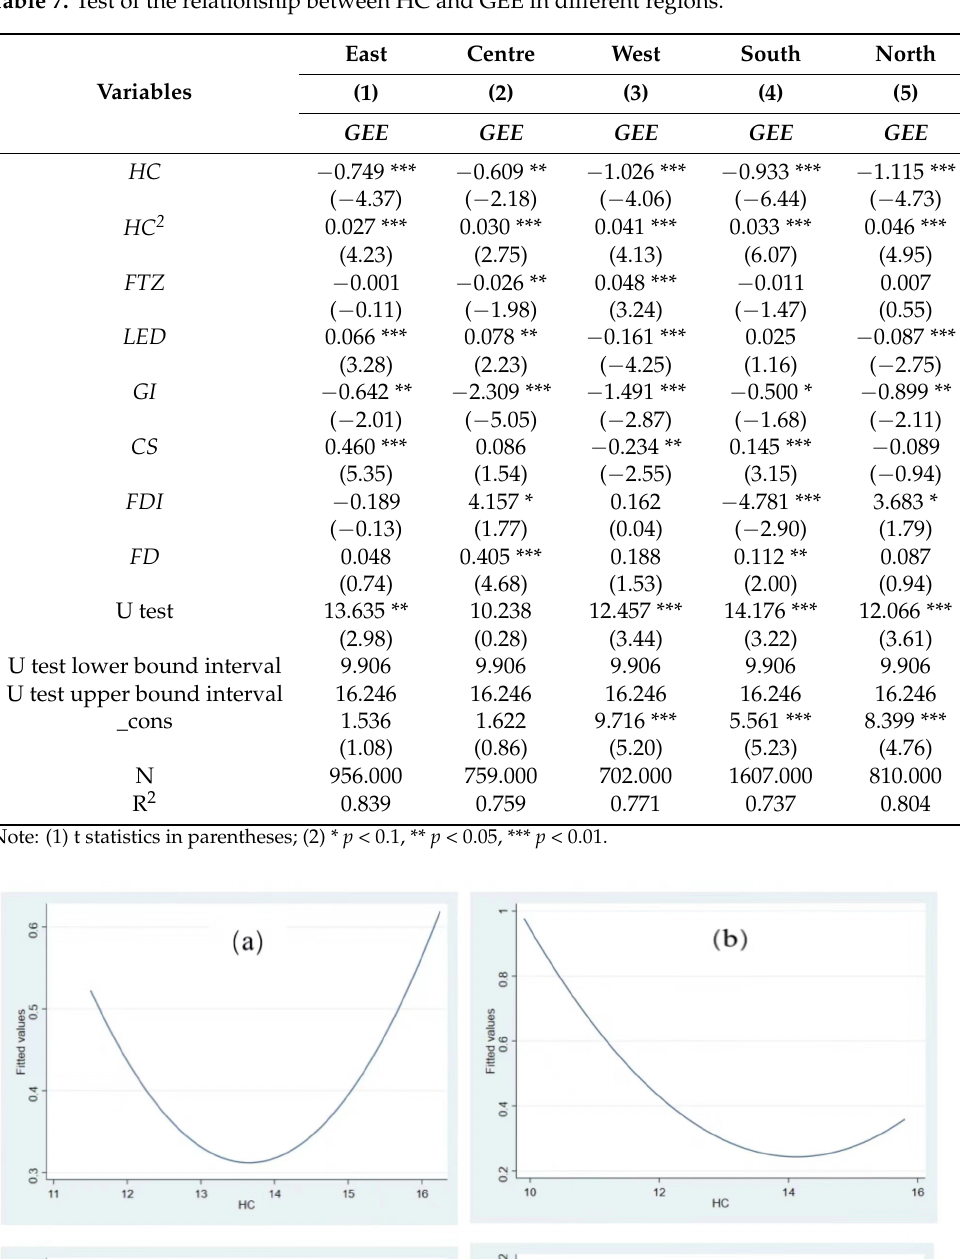
Table 7. Test of the relationship between HC and GEE in different regions.